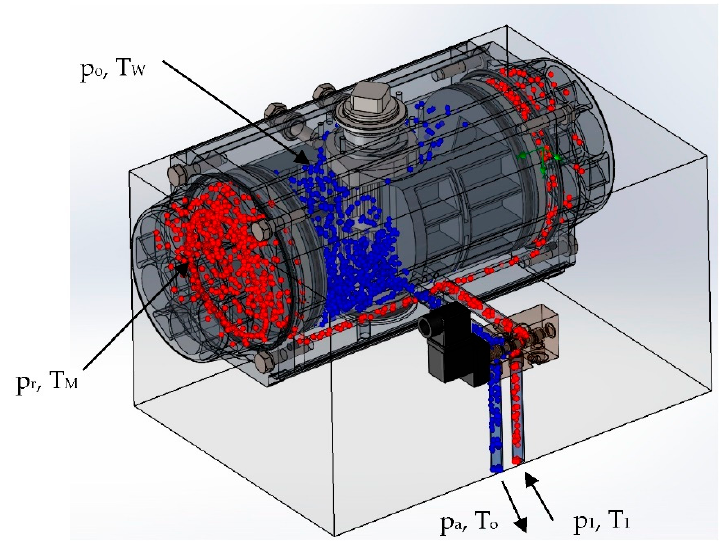
Figure 3. View of the pneumatic discharge system with marked compressed air paths (red—high pressure; blue—low pressure), where: p a —atmospheric pressure, p o —pressure in the evacuated chamber, p r —pressure in the working chamber, T o —ambient temperature, T 1 —supply air tempera- ture, T M —air temperature in the working chamber, T W —air temperature in the evacuated chamber.